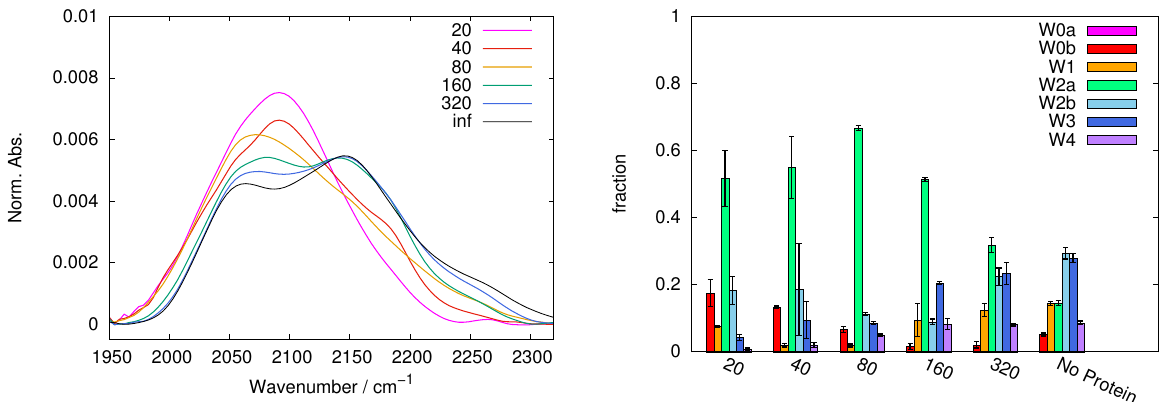
Figure 3. As for Figure 1, in protein + maltose matrices. The WAB behaviour is more similar to the trehalose than to the sucrose case. However, a sizable transition is still observed between S/P = 20 and 40, as well as between 80 and 160.